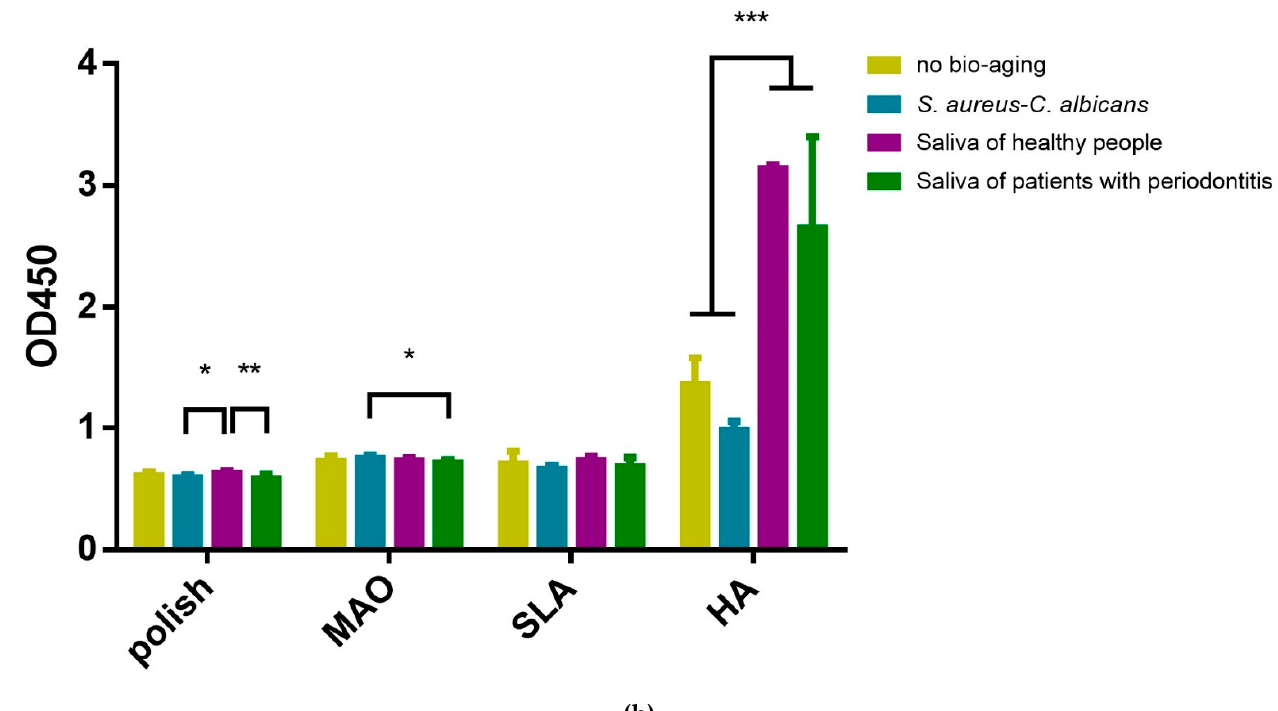
Figure 5. ( a ) The adhesion of multi-species biofilms ( S. sanguis , P. gingivalis, and F. nucleatum ) are measured by laser confocal microscopy at 72 h; ( b ) Metabolic activity is tested by CCK-8 test at 72 h. n = 5 (* p < 0.05, ** p < 0.01, *** p < 0.001).